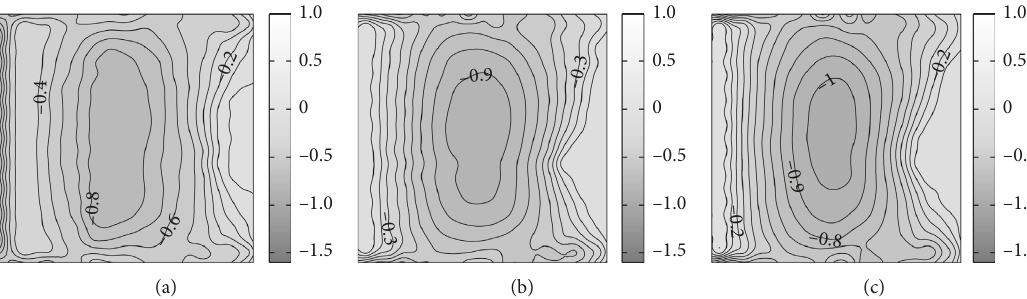
Figure 15: Contours of mean pressure coefficients on cylindrical roofs with optimal and near optimal rise-to-span ratios. (a) R / S � 1/7. (b) R / S � 1/5.5. (c) R / S �